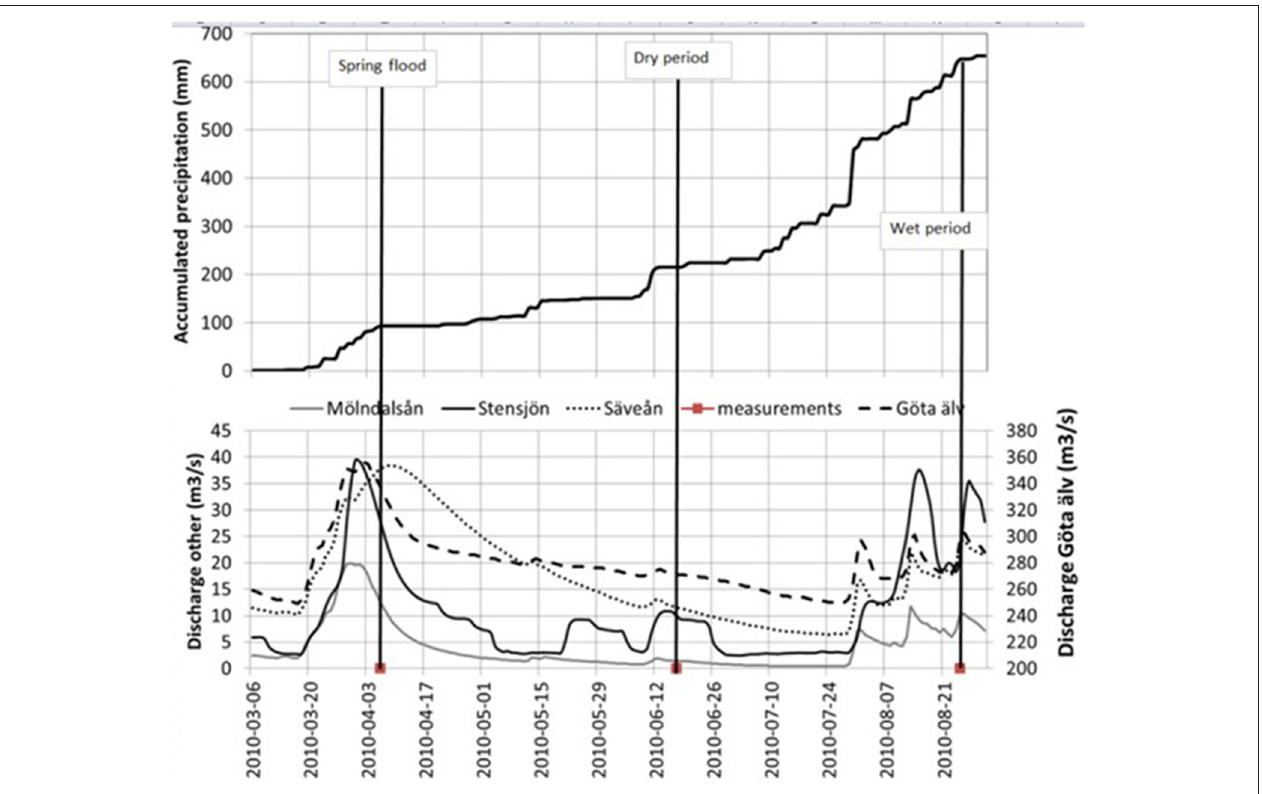
FIGURE 2 | Accumulated precipitation in Gothenburg (Top) . Discharge (Bottom) in different rivers during the same period. Discharge from Stensjön is based on measurements and the others on modeling (Hype model). The River Göta Älv data is plotted on the right